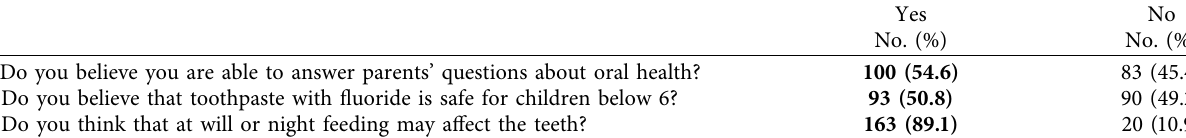
Table 5: Paediatricians’ attitude